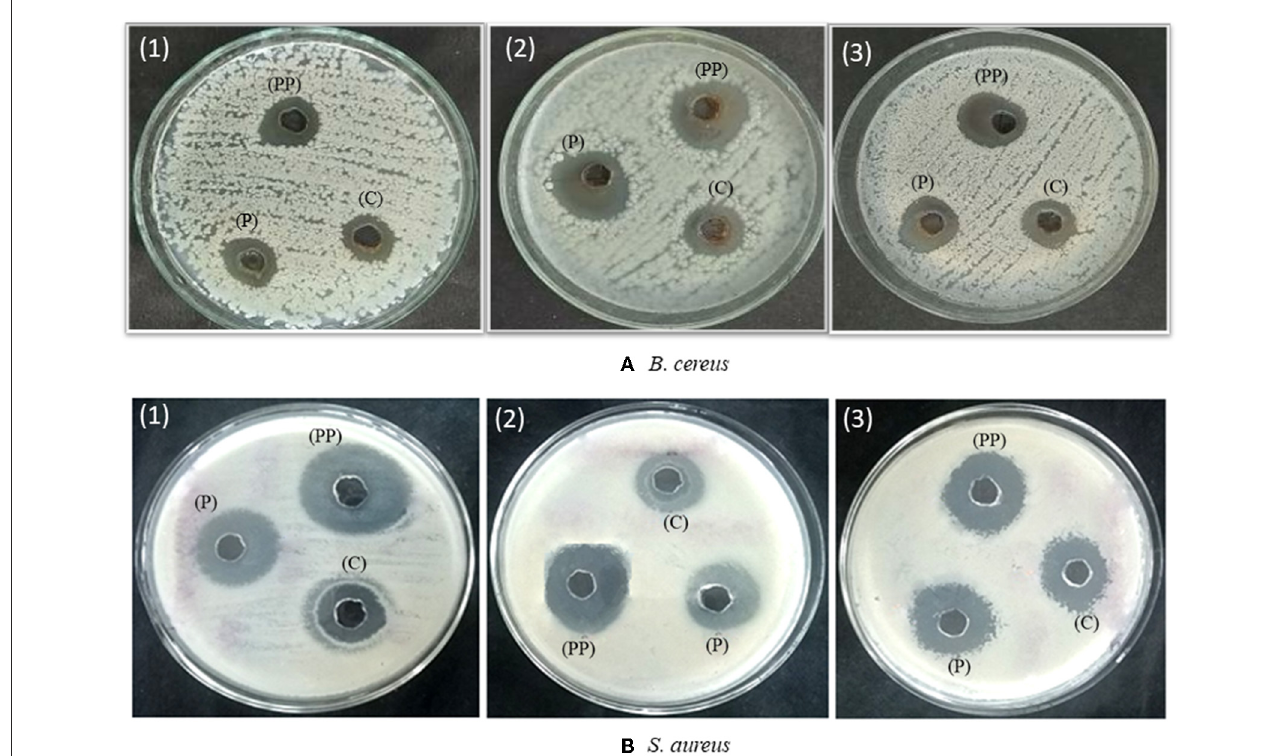
FIGURE2 Antimicrobial activity of crude (c), partially purified (PP), and purified bacteriocin (P) of probiotics (1) L. crustorum F11 (2) L. spicheri G2 (3) L. pentosus S6 against (A) Bacillus cereus and (B) Staphylococcus aureus .